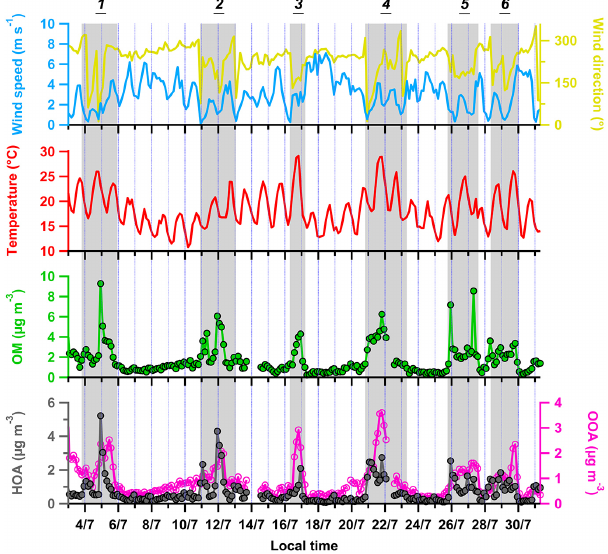
Figure 2. Time series of meteorological parameters (wind speed and direction, temperature), of the organic matter, and of the two PMF factors HOA and OOA in suburban Paris (SIRTA) in summer 2009. The grey-shaded areas highlight the “Atlantic Polluted” wind regimes associated with stagnant conditions and increased